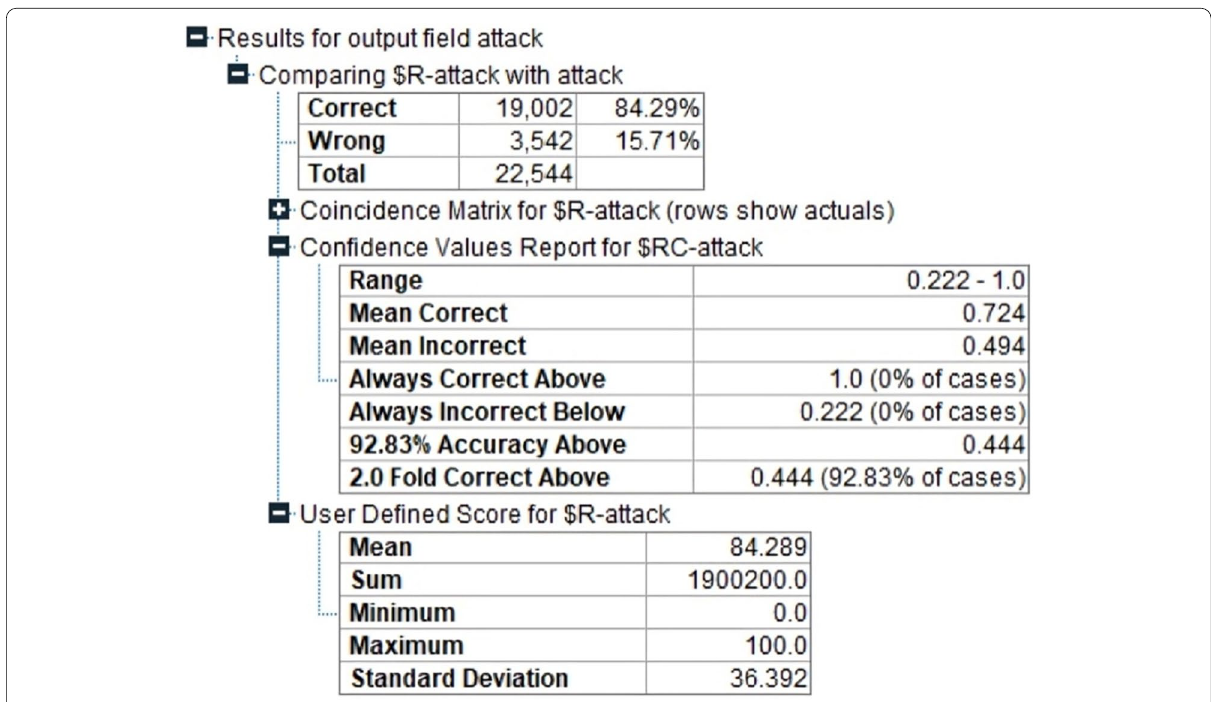
Fig. 11 Accuracy level in Random Forest